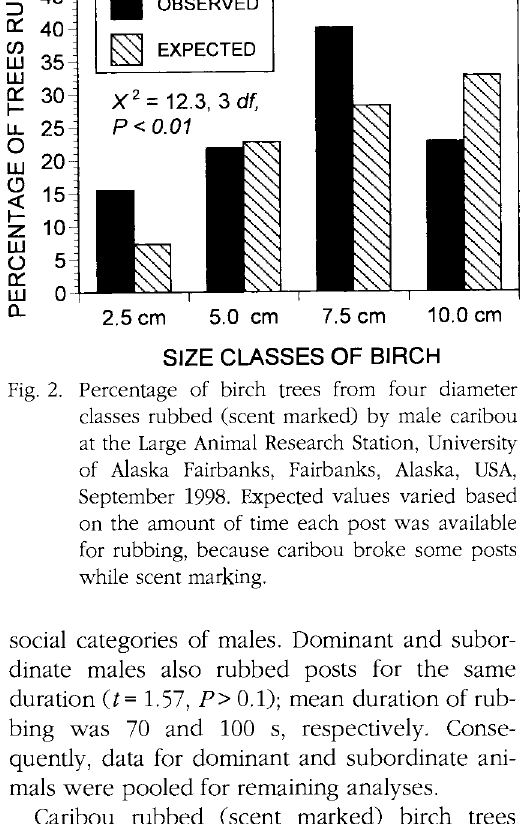
social categories of males. Dominant and subor